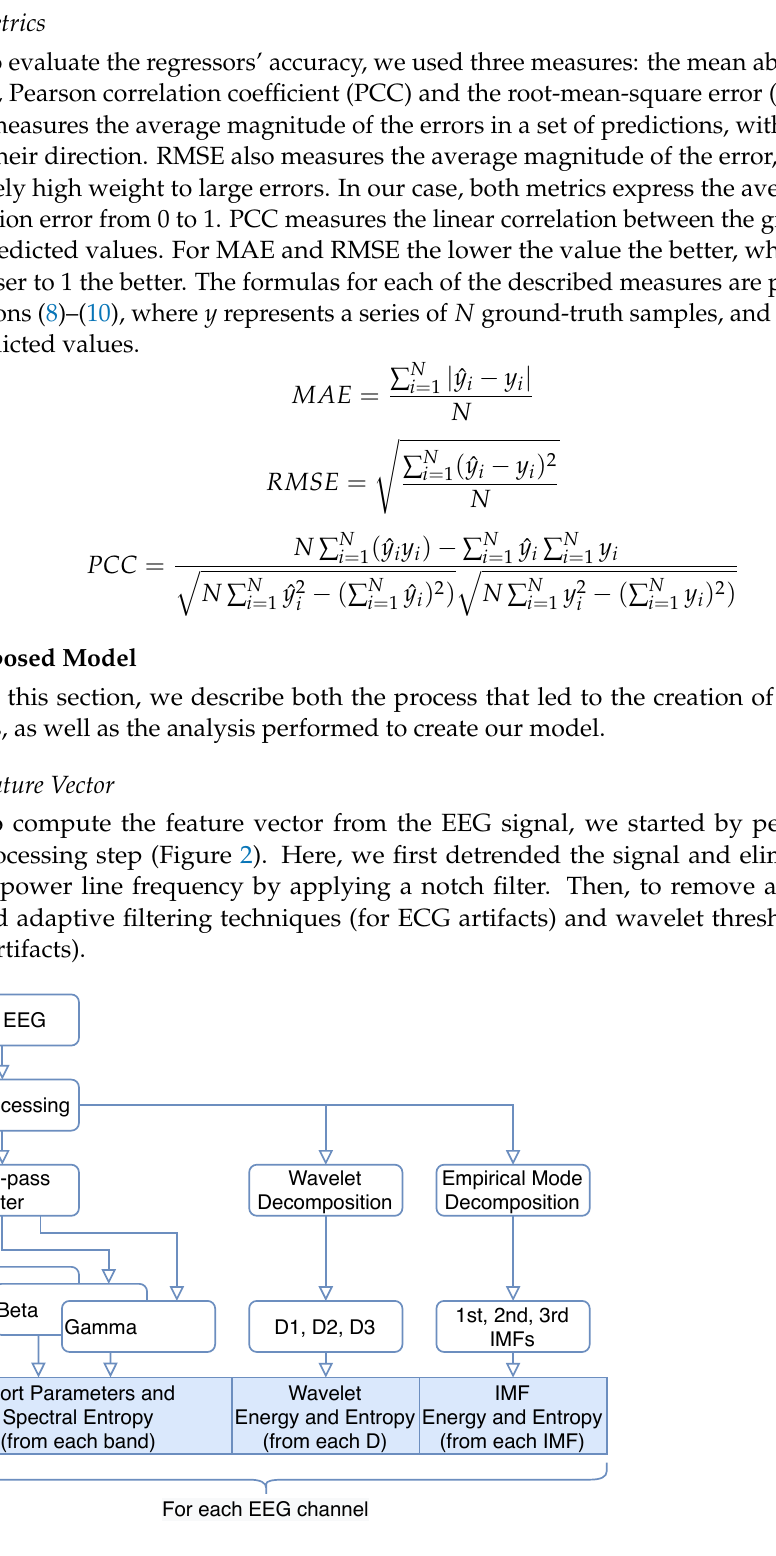
Figure 2. Steps to compute the feature vector from the raw EEG signal. To extract the alpha, beta and gamma bands, we applied three FIR band pass filters to the EEG signal. Then, we computed the Hjorth parameters and Spectral Entropy for each of the bands. Wavelet and IMF-based features were calculated using the signal obtained after the pre-processing step, because these algorithms are